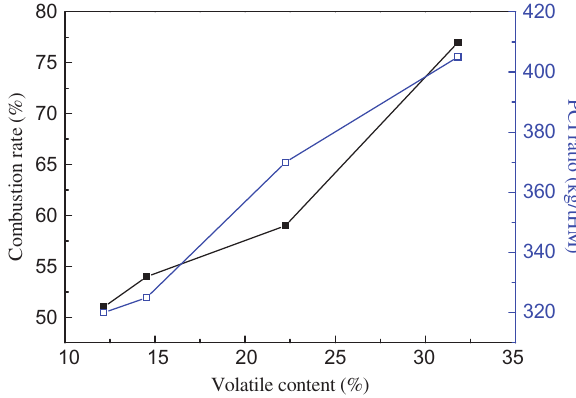
Figure 4: Experimental results of coal ’ s combustion rate with dif- ferent volatile